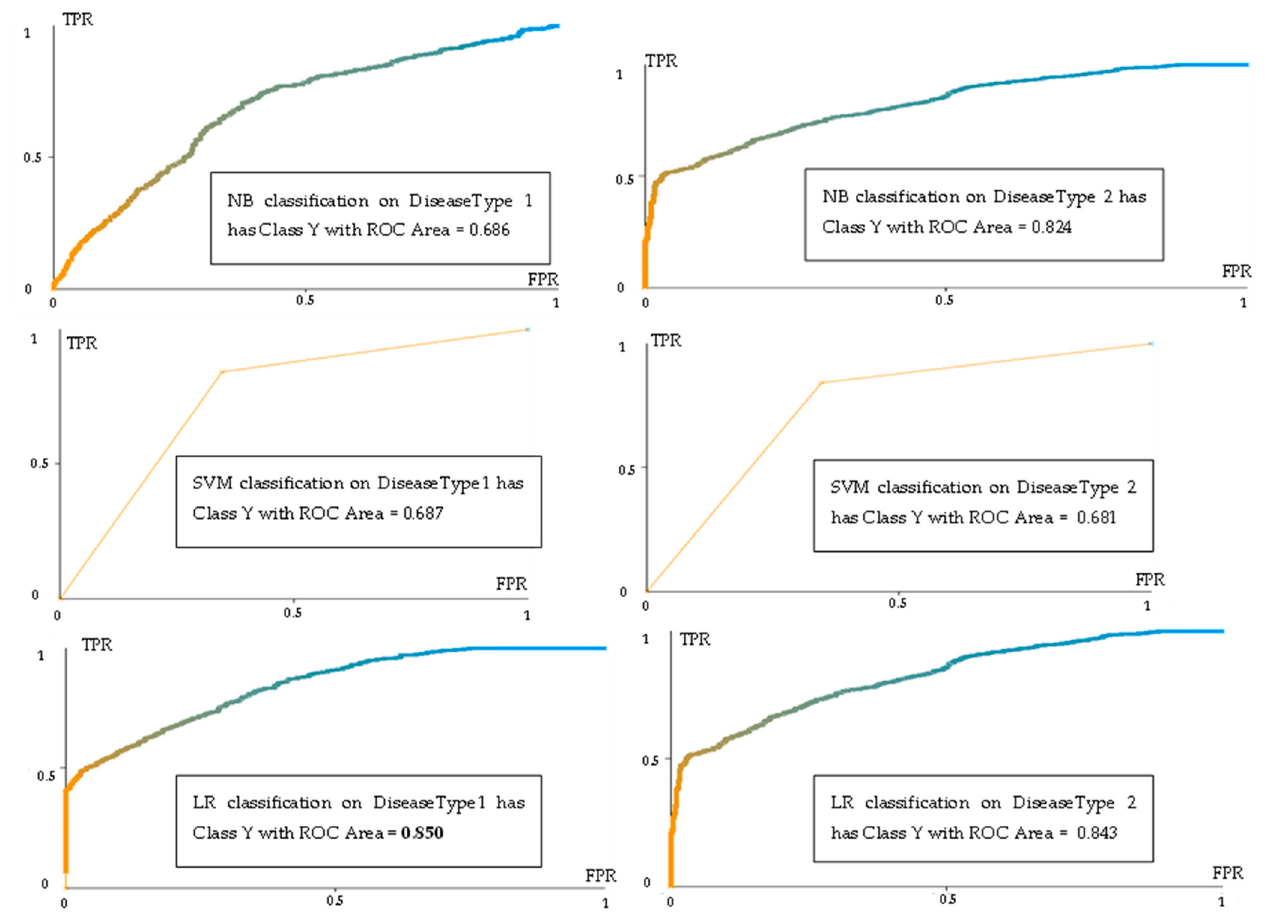
Figure 9. Show ROC curves of NB, SVM, and LR classifiers of each disease type, i.e., Type 1 and Type 2 (TPR is True Positive Rate; FPR is False Positive Rate).